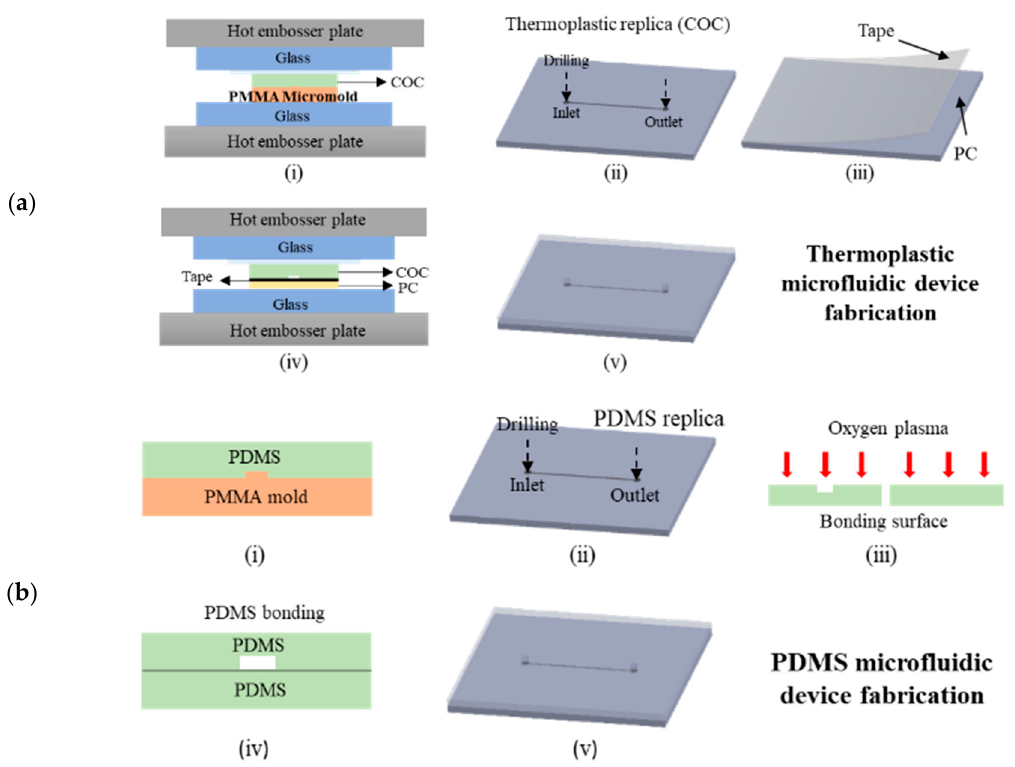
Figure 8. ( a ) Thermoplastic microfluidic device fabrication by hot embossing. ( a-i ) Imprinted COC substrate from a PMMA micromold, ( a-ii ) drill inlet / outlet reservoirs, ( a-iii ) dry adhesive tape applied to the cover substrate ( a-iv ), bond to COC layer, and ( a-v ), completed hot embossing process; ( b ) polydimethylsiloxane (PDMS) microfluidic device obtained by casting. ( b-i ) PDMS from a PMMA micromold ( b-ii ), drill inlet / outlet reservoirs ( b-iii ) oxygen plasma treatment ( b-iv ), bond to PDMS device, and ( b-v ) completed casting process.